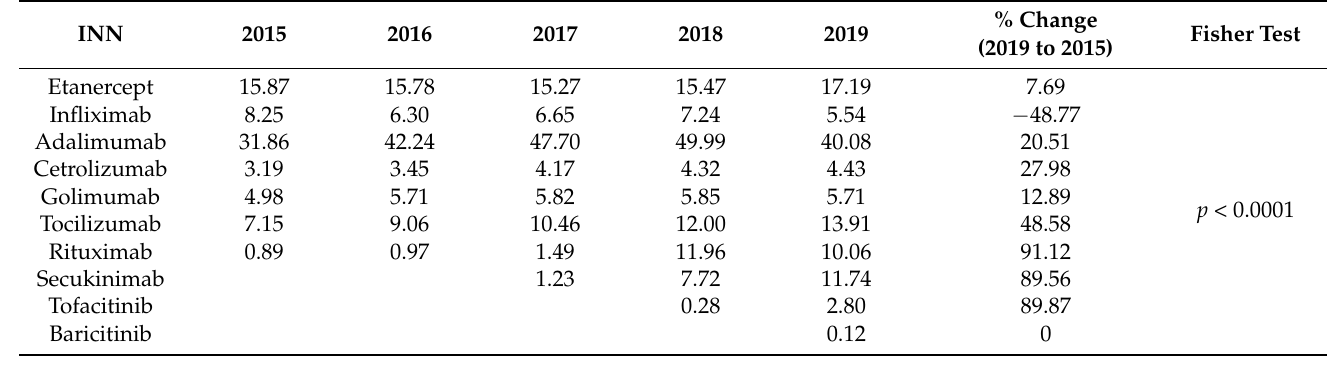
Table 3. Reimbursed expenditures in monetary units (in millions of BGN).